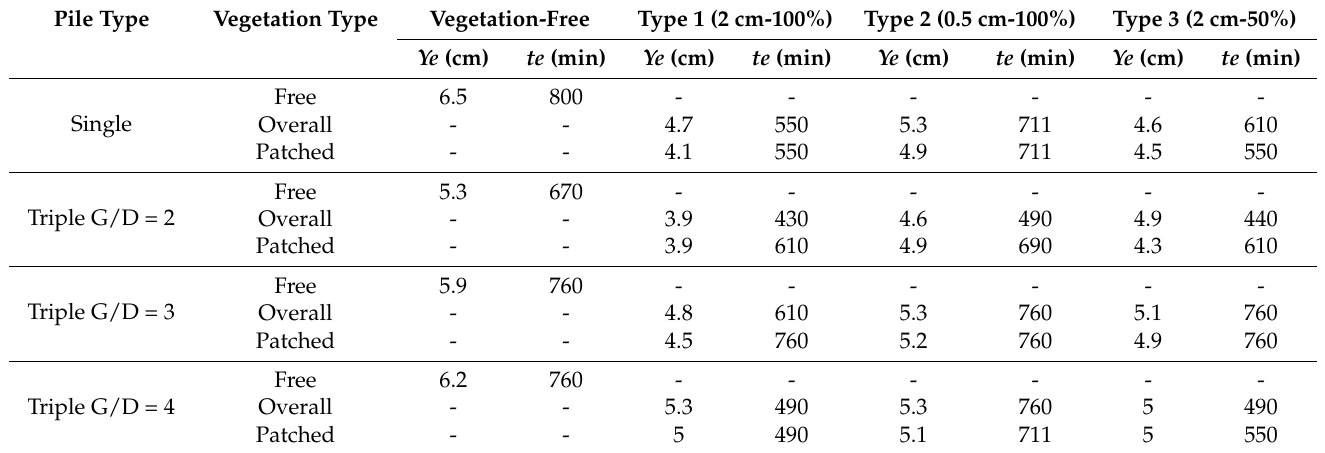
Table 3. The equilibrium time and depth for each experimental